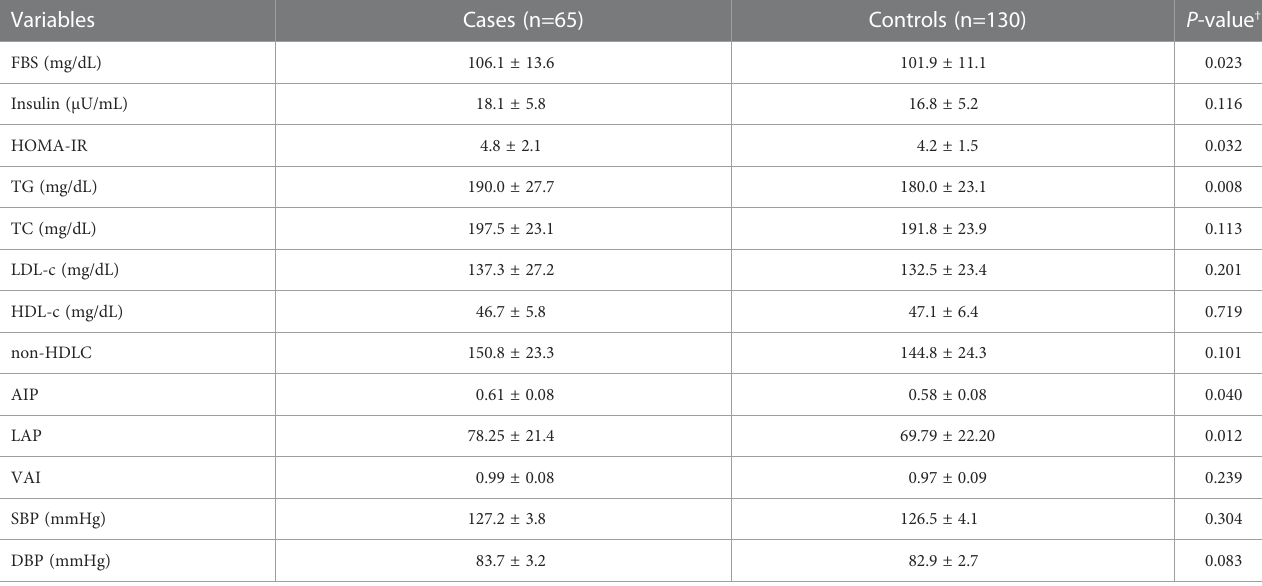
TABLE 2 Comparison of cardiometabolic parameters between cases and controls.